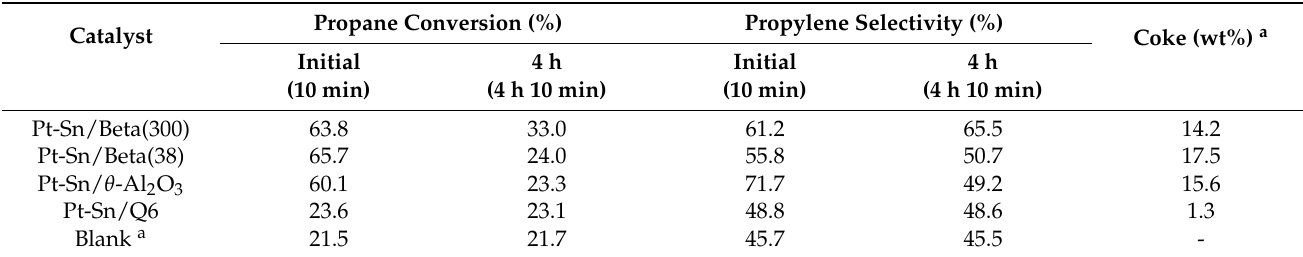
Figure 7. Catalytic performances over different supported Pt-Sn catalysts in propane dehydrogena- tion (PDH) at 620 ◦ C: ( a ) propane conversion (%) and ( b ) propylene selectivity (%). Table 4. Propane conversion, propylene selectivity, and the amount of coke formed over supported Pt-Sn catalysts during PDH at 620 ◦